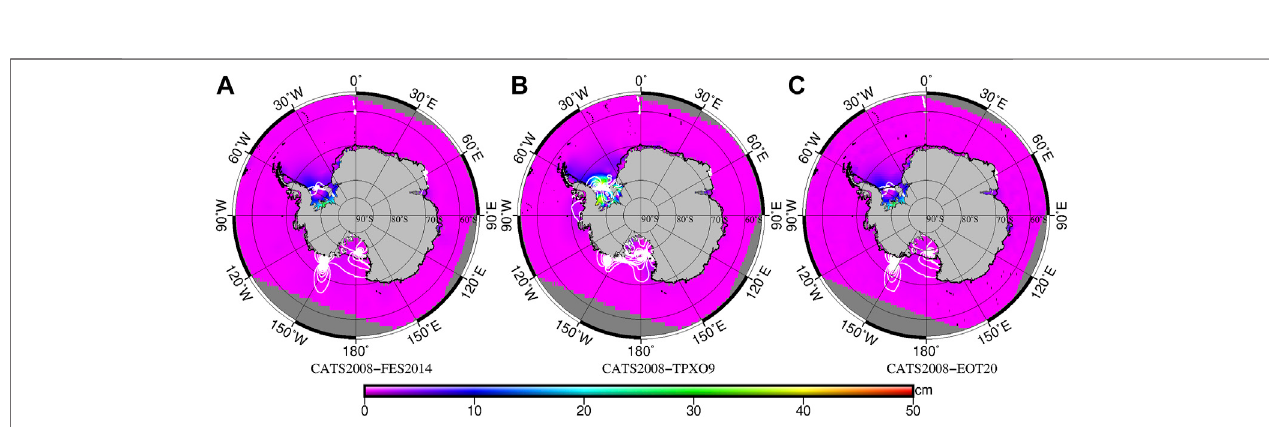
FIGURE3| CotidalchartoftheK1constituentof (A) CATS2008, (B) FES2014, (C) TPXO9,and (D) EOT20.Grayvaluesin (A) arelocationsbeyondthegeographic coverage of CATS2008. The color scale represents the amplitude value; white contour lines represent the phase lag ( ° ).